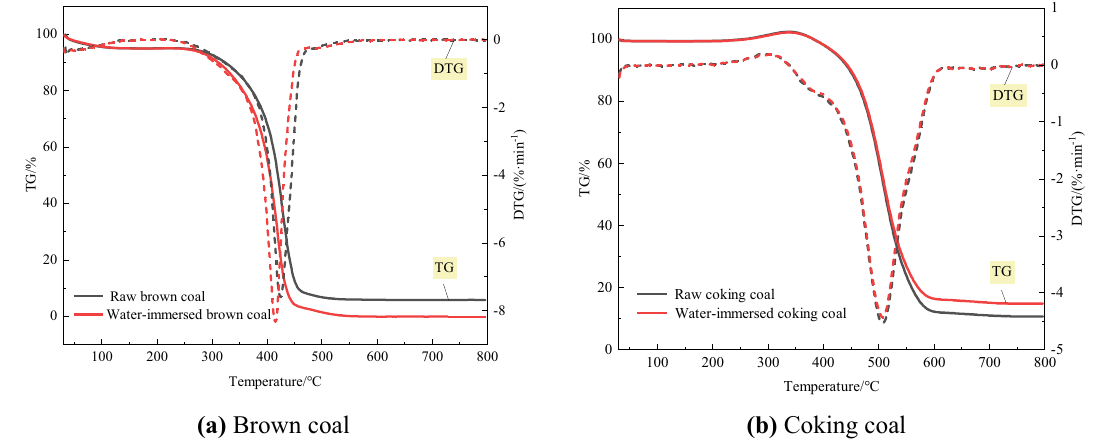
Figure 2. Thermal analysis curves of raw coal samples and water-immersed coal samples immersion. Sample name